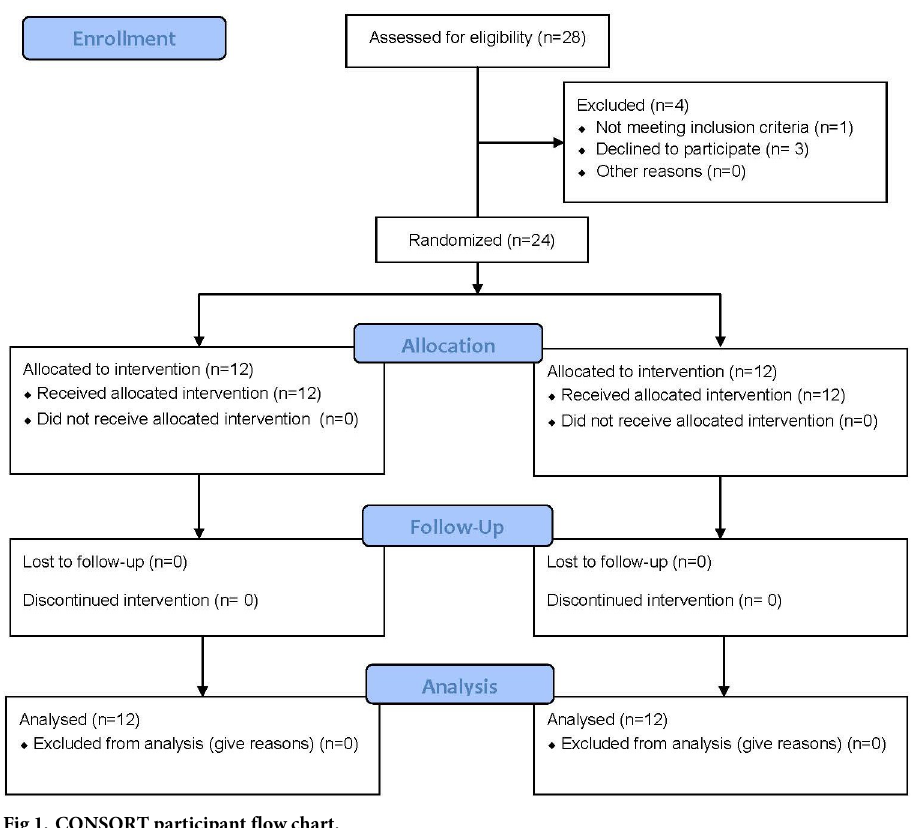
Fig 1. CONSORT participant flow